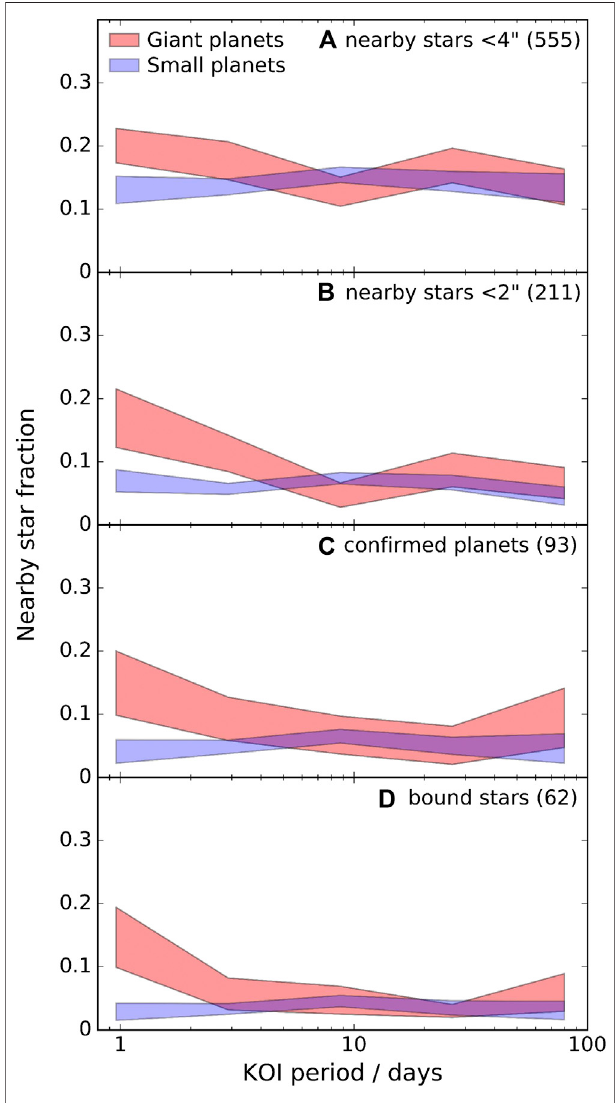
FIGURE 4 | The binary fraction for two planetary populations (giant and small) is shown as a function of orbital period, with 1 σ uncertainty regions shaded. The top panel is the original sample, with each subsequent panel removing systems, as described in the text, to clean the sample. In each panel, the number of systems used is shown in